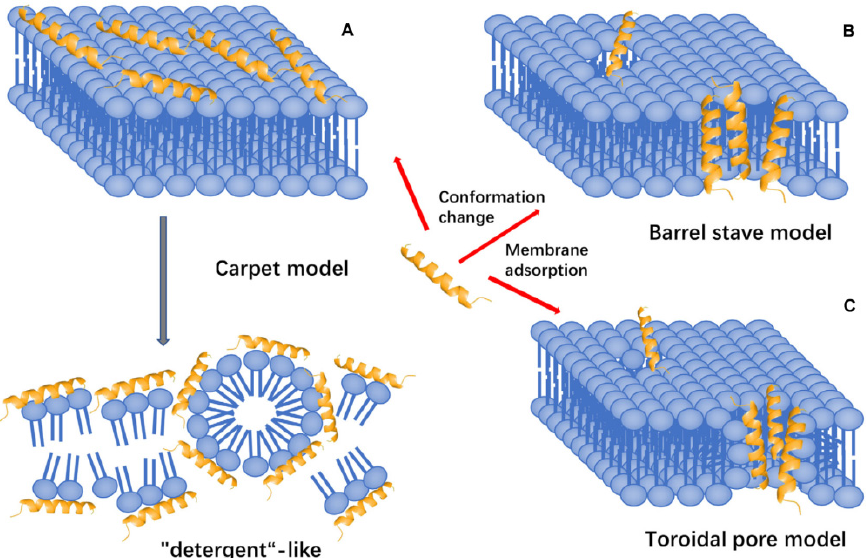
Figure 16. AMP’s mode of action ( A ) Carpet model: attaching of AMPs on the surface of the membrane and destroying the cell membrane like a “detergent.” ( B ) Barrel stave model: AMPs aggregate with each other, diffuse into the cell membrane, and form a channel. ( C ) Toroidal pore model: accumulation of AMPs vertically embeds in the cell membrane, which leads to bending to make a ring hole [138].